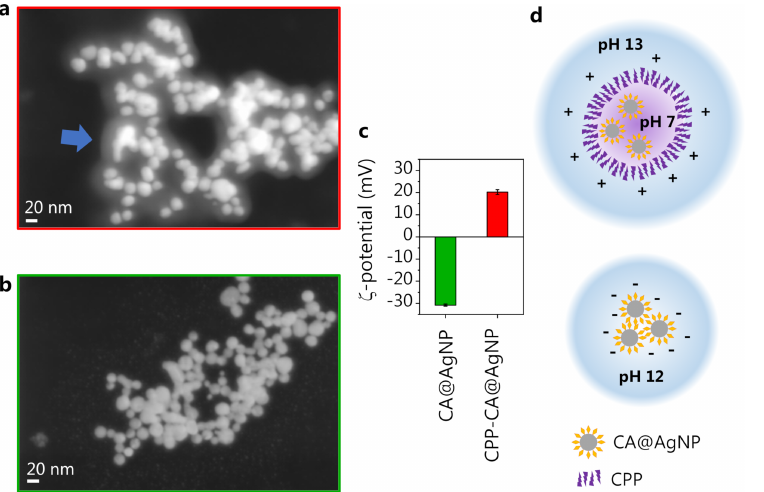
( a ) CPP-CA@AgNP SEM